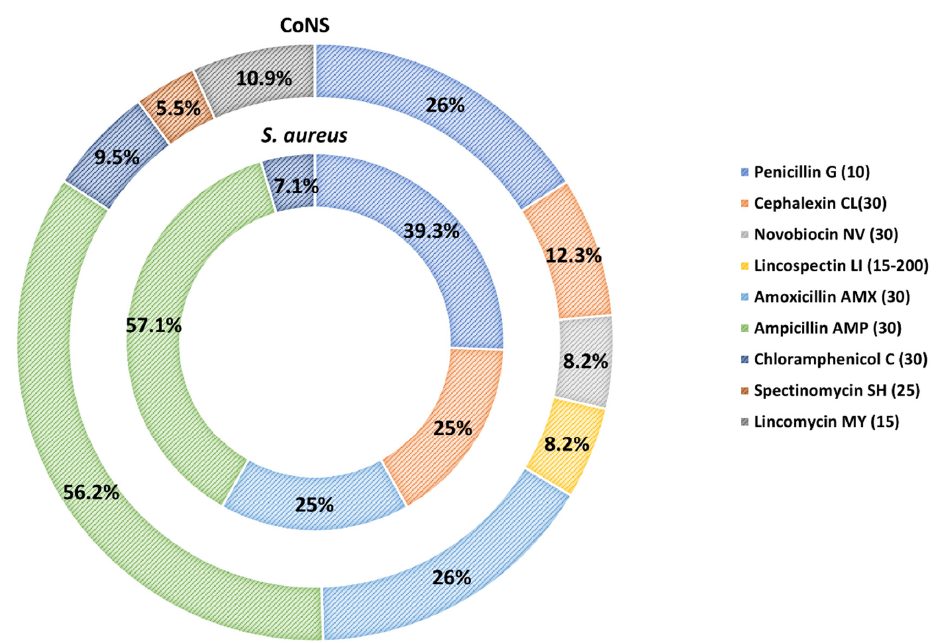
Figure 2. Resistance pattern of the S. aureus and CoNS strains to specific antimicrobials in the disk diffusion assay.